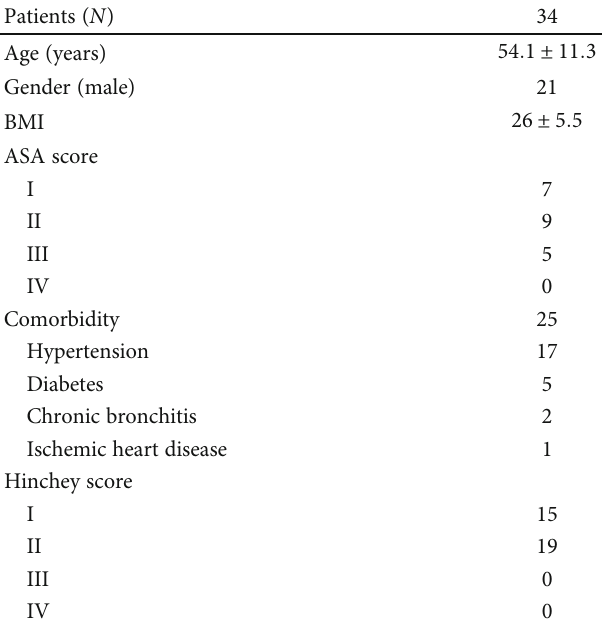
Table 1: Patients ’ and diseases ’ characteristics.